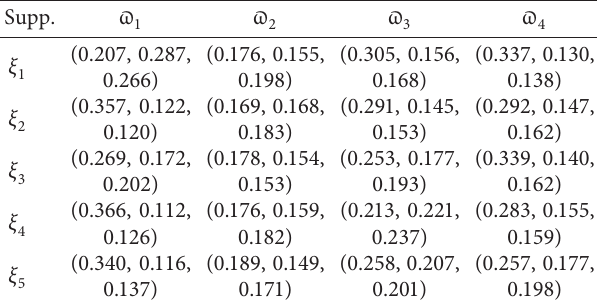
Table 18: Aggregated weighted picture fuzzy decision matrix. Supp.